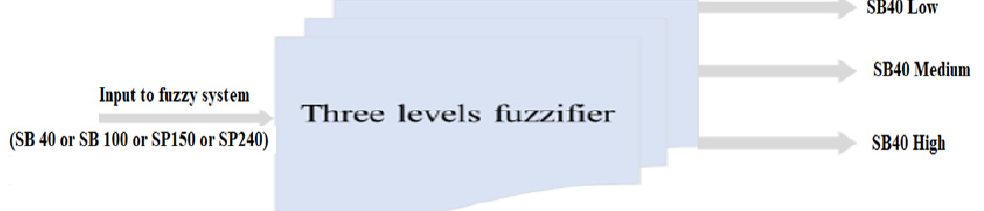
Figure 8. Fuzzification of fuzzy system inputs.